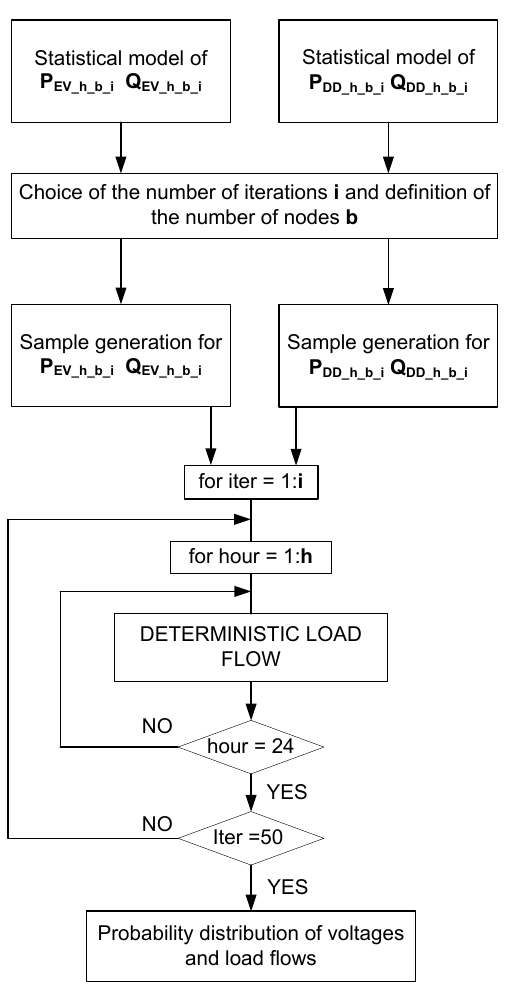
Figure 1. Flow diagram for the general